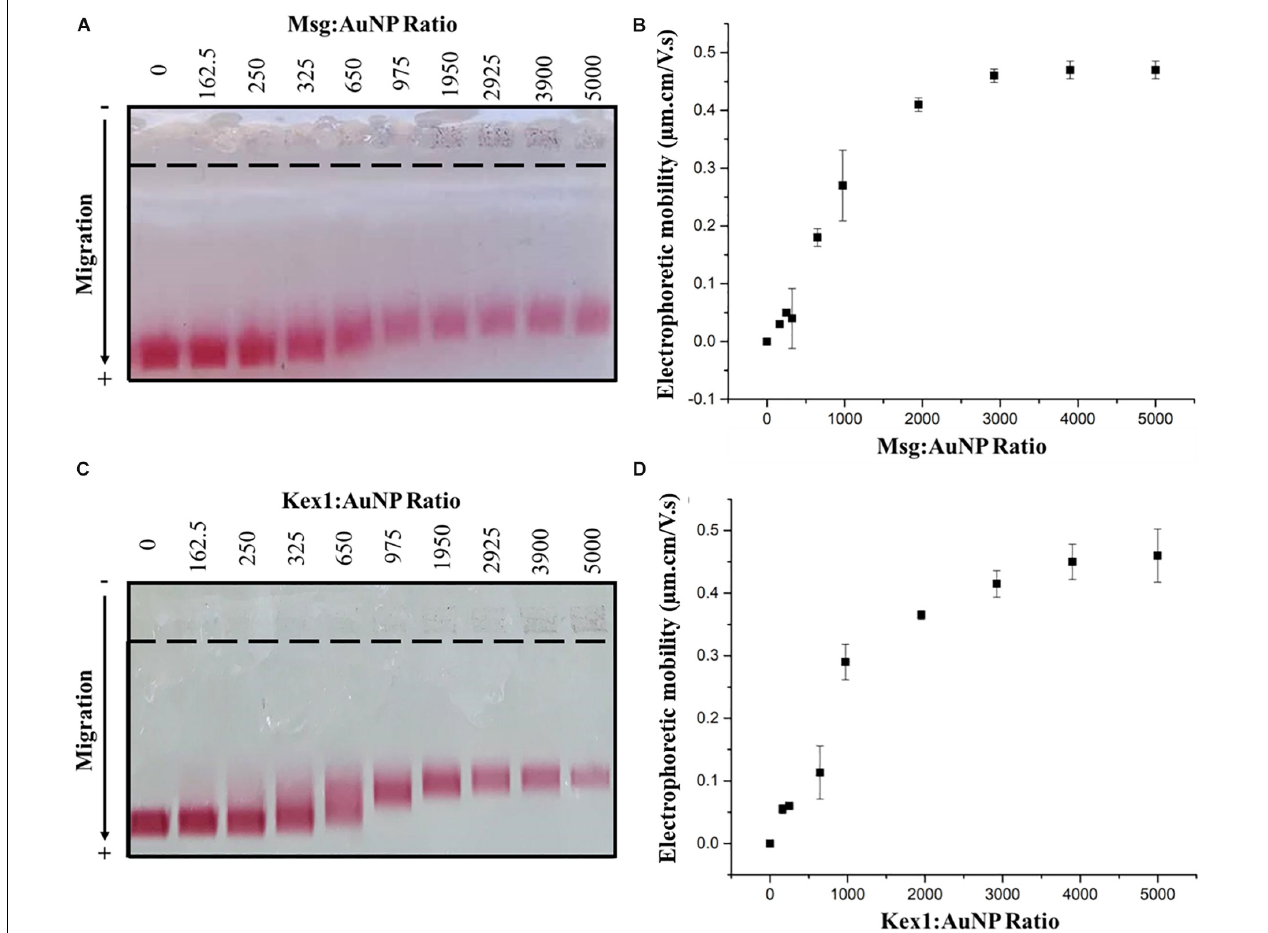
FIGURE 4 | AuNP-RSA conjugates formation. Agarose gel electrophoresis at increasing ratios of Msg RSA to AuNPs (A) and Kex1 RSA to AuNPs (C) , showing the migration of each conjugate bands toward the positive electrode. Differences between the electrophoretic mobility of the AuNPs alone and AuNP-Msg (B) or AuNP-Kex1 (D) conjugates at increasing ratios, calculated from the migration distances in gel. The nine ratios (162.5–5000) correspond to protein concentrations of 9.75, 15, 19.5, 39, 58.5, 117, 175.5, 234, and 300 nM. Standard deviation bars correspond to duplicate